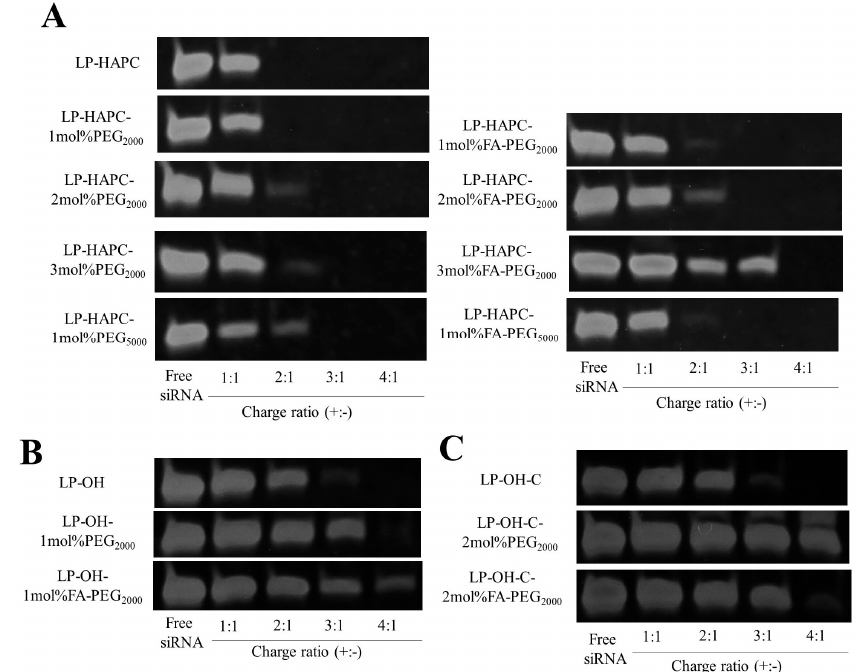
Figure5. EffectofFA-PEG-modificationofcationicliposomesonassociationofsiRNAwithFA-PEG-modified Figure 5. Effect of FA-PEG-modification of cationic liposomes on association of siRNA with cationic FA-PEG-modified cationic liposomes. siRNA association by cationic liposomes was analyzed by gel retardation assay.